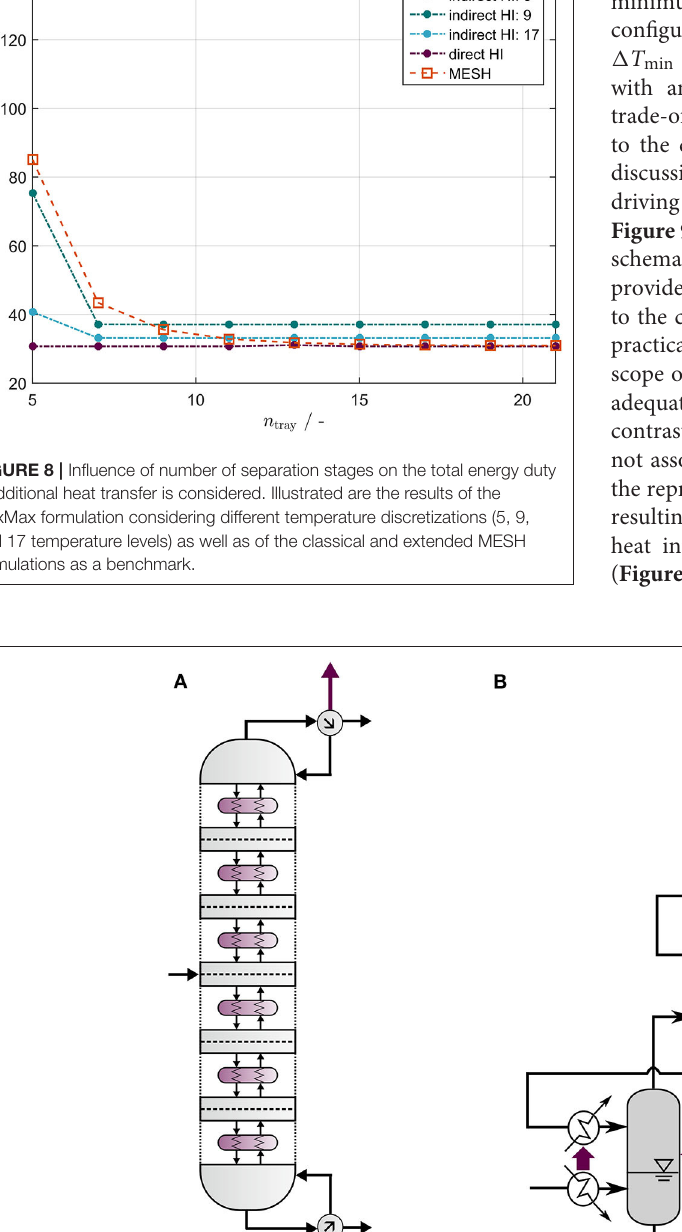
Frontiers in Energy Research |